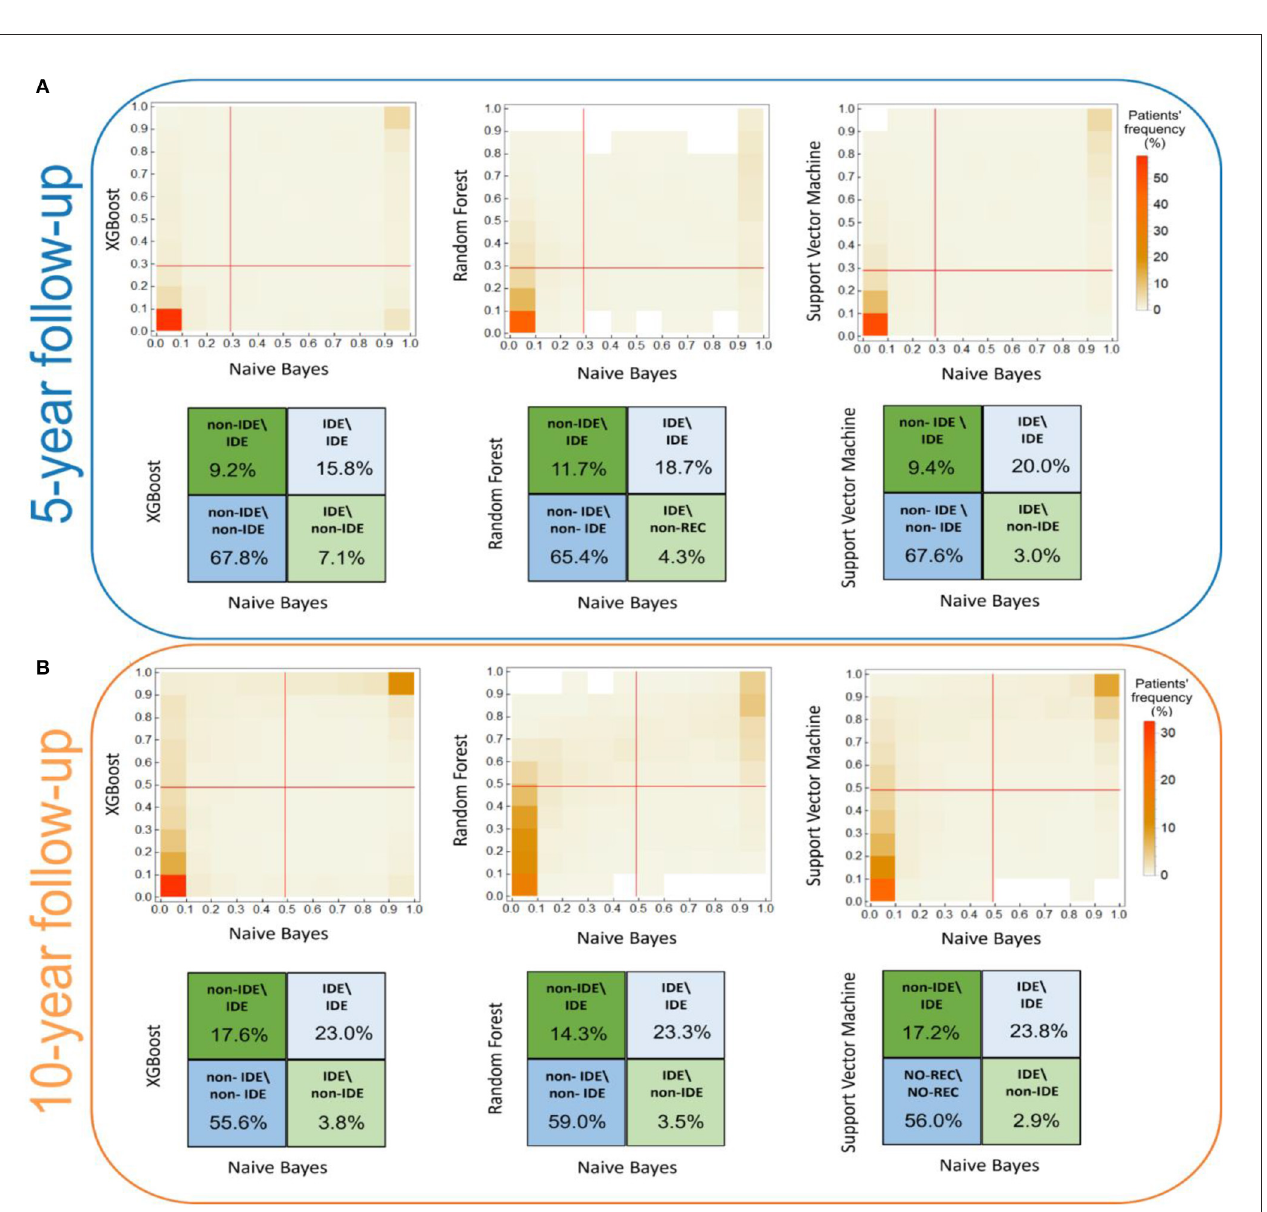
FIGURE2 Score concordance maps and concordance tables for (A) the 5-year IDE prediction model and (B) the 10-year IDE prediction model. (A, B) The concordance maps (upper panel) represent the average histograms over 20 five-fold cross validation rounds of the classification score pairs, computed by the classifiers indicated in each axis. Red lines are referred to the score thresholds to assign a patient to the IDE class. (A, B) The concordance tables quantify the classification agreement (expressed in percentage values) among pairs of classifiers. Higher and lower intensity colors refer to higher and lower percentage values along the diagonals,